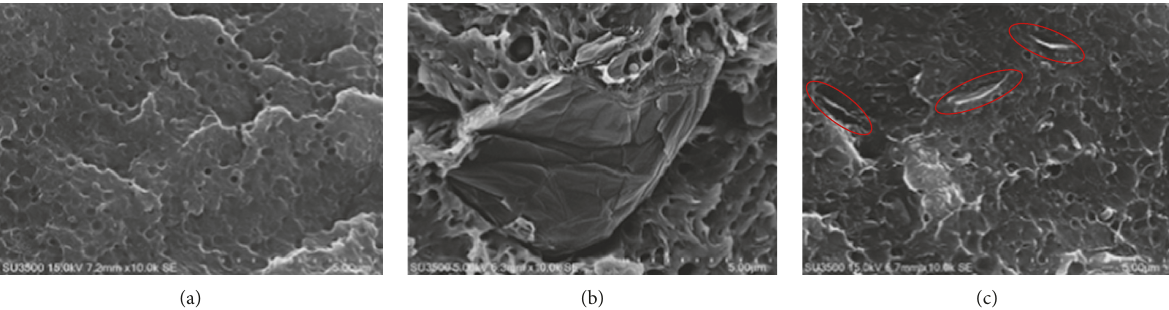
Figure 5: SEM images of (a) ABS, (b) ABS/GO (dry mixing), and (c) ABS/GO (solvent mixing) composite filaments.